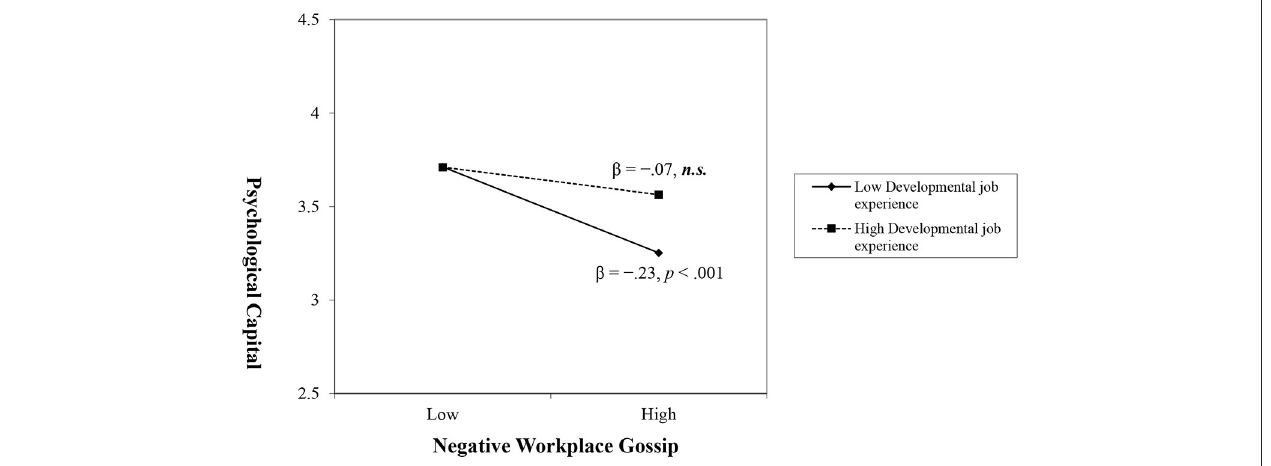
FIGURE 2 | Moderating effect of developmental job experience on the relationship between workplace negative gossip and psychological